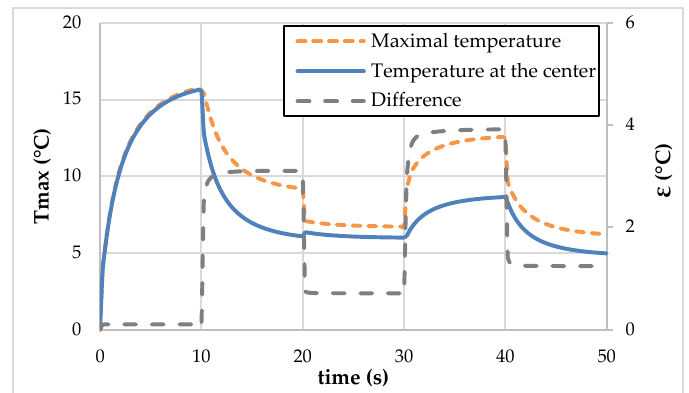
Figure 15. Temporal evolution of the maximum temperature reached by the BGA and the temperature at the center of the chip—Difference between those two quantities.